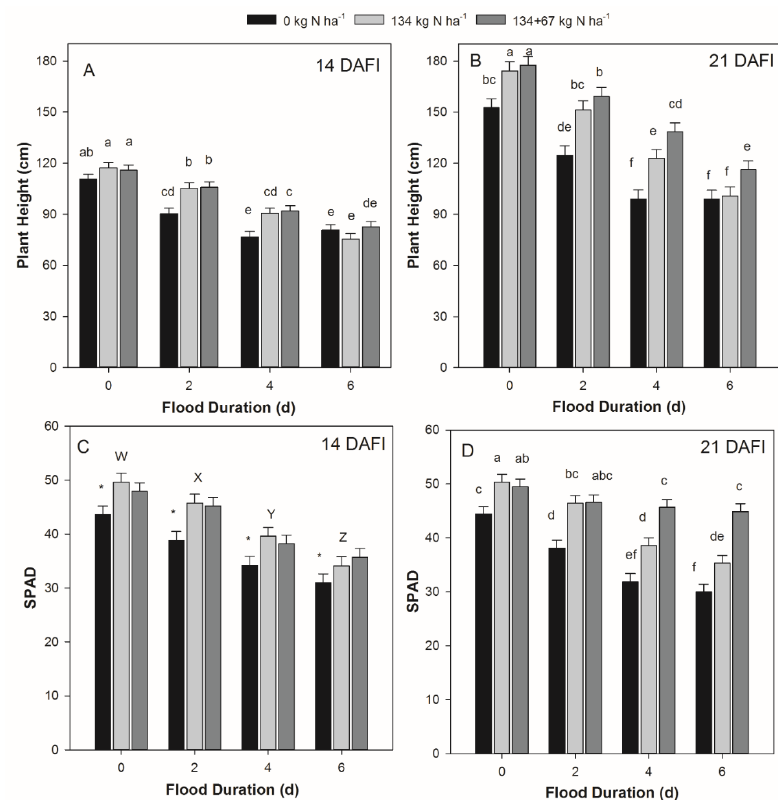
Figure 1. ( A ) Plant height 14 days after flood initiation (DAFI), ( B ) plant height 21 DAFI, ( C ) leaf greenness 14 DAFI, and ( D ) leaf greenness 21 DAFI for each flood duration (FD) and N application rate (NMP) of 0, 134, or 134 + 67 kg N ha − 1 . Error bars denote standard error of the mean. When present, different lowercase letters within a panel indicate differences in means for the FD × NMP interaction. Uppercase letters denote differences in FD across NMP, and an asterisk denotes a significantly lower mean for the specified NMP (across FD) when the FD × NMP interaction was non-significant.